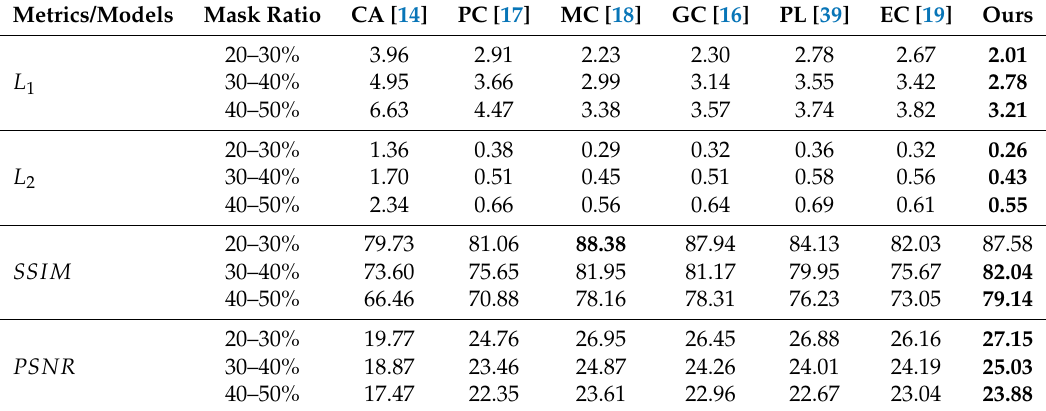
Table 2. Quantitative comparison on ImageNet dataset [22].